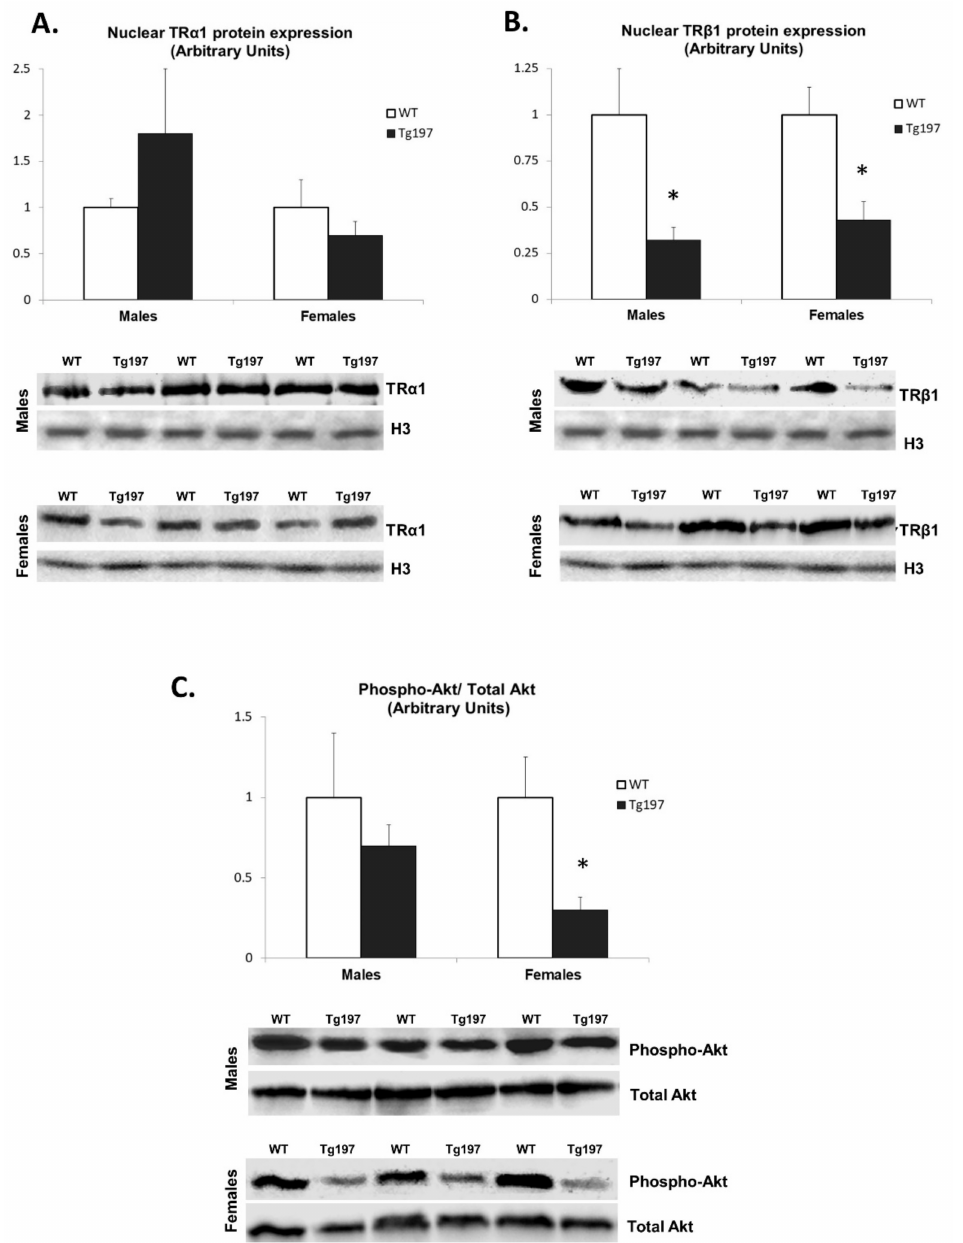
Figure 2. Reduction of TR β 1 in Tg197 LV samples and female-specific reduction of Akt activation. Densitometric assessment in arbitrary units and representative Western blots of thyroid hormone receptor α 1 nuclear expression (TR α 1, A ), thyroid hormone receptor β 1 nuclear expression (TR β 1, B ) and phosphorylated and total p38 MAPK ( C ) in left ventricle of WTC57BL/6JxCBA (WT, n = 4 per gender) and Tg197 ( n = 6 per gender) male and female mice. Values are represented in mean ± SEM; * p < 0.05 (H3: Histone